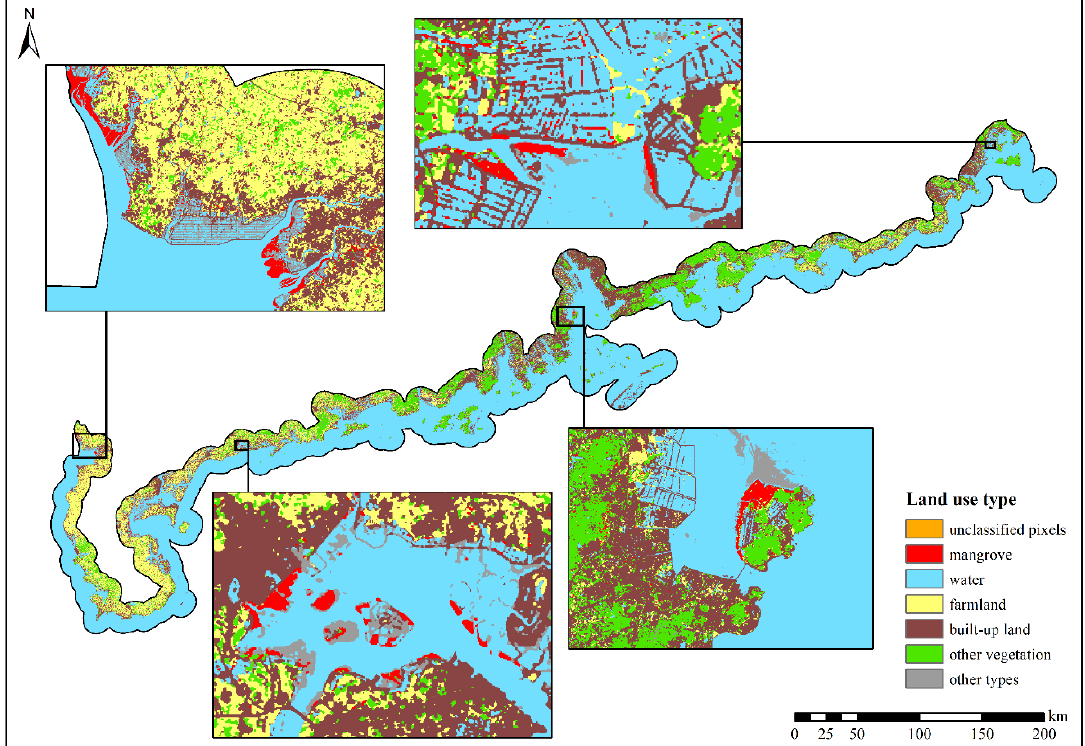
Figure 4. Classification results derived from Landsat image collected in